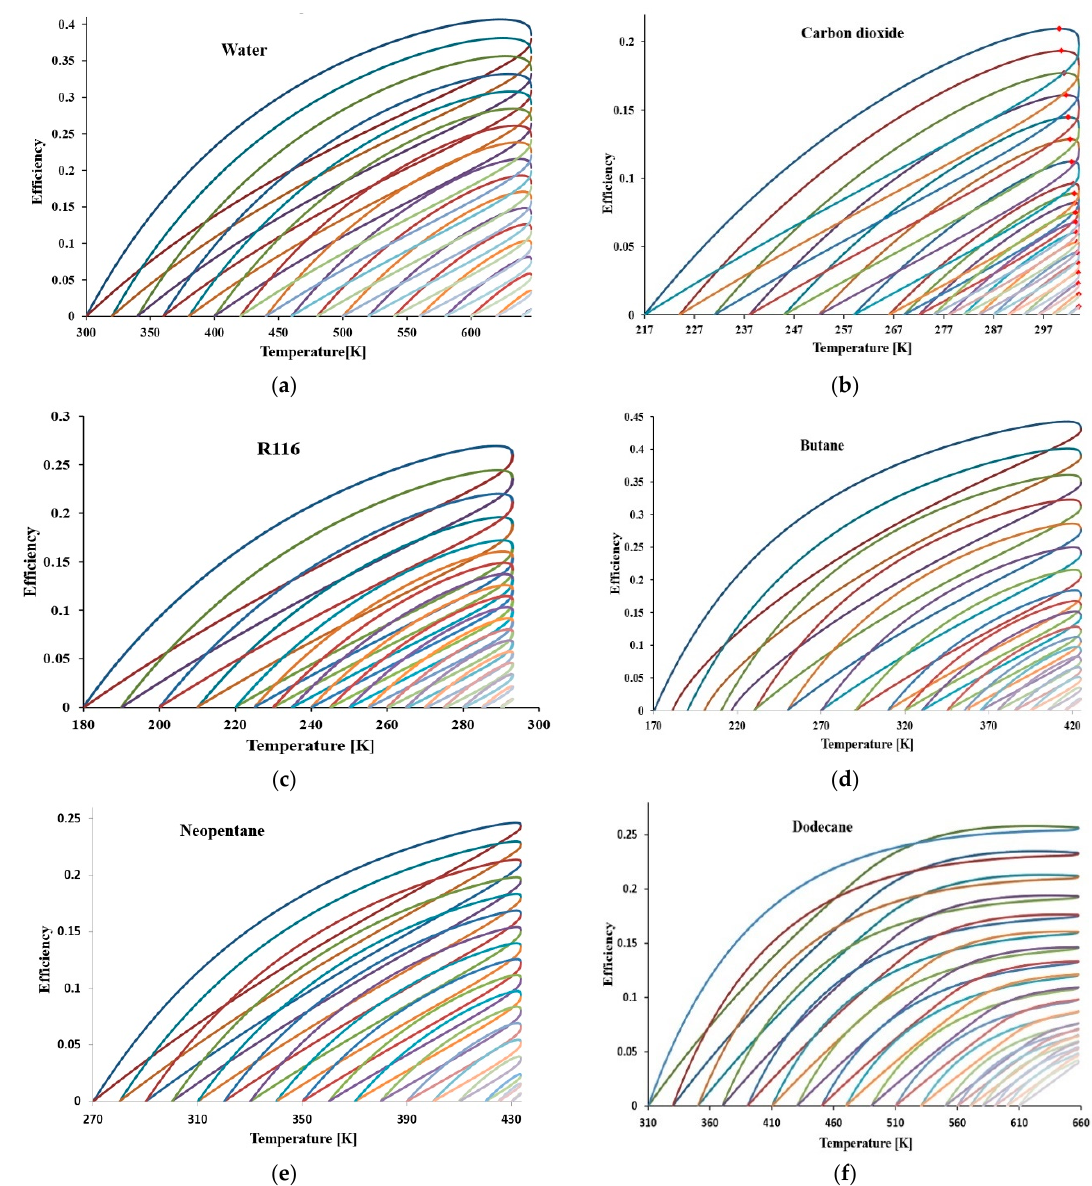
Figure 5. Temperature dependencies of ORC (or other Rankine-like cycles) and TFC cycles for various working fluids (Water ( a ), CO 2 ( b ), R116 ( c ), Butane ( d ), Neopentane ( e ), Dodecane ( f )); see text for further explanation.